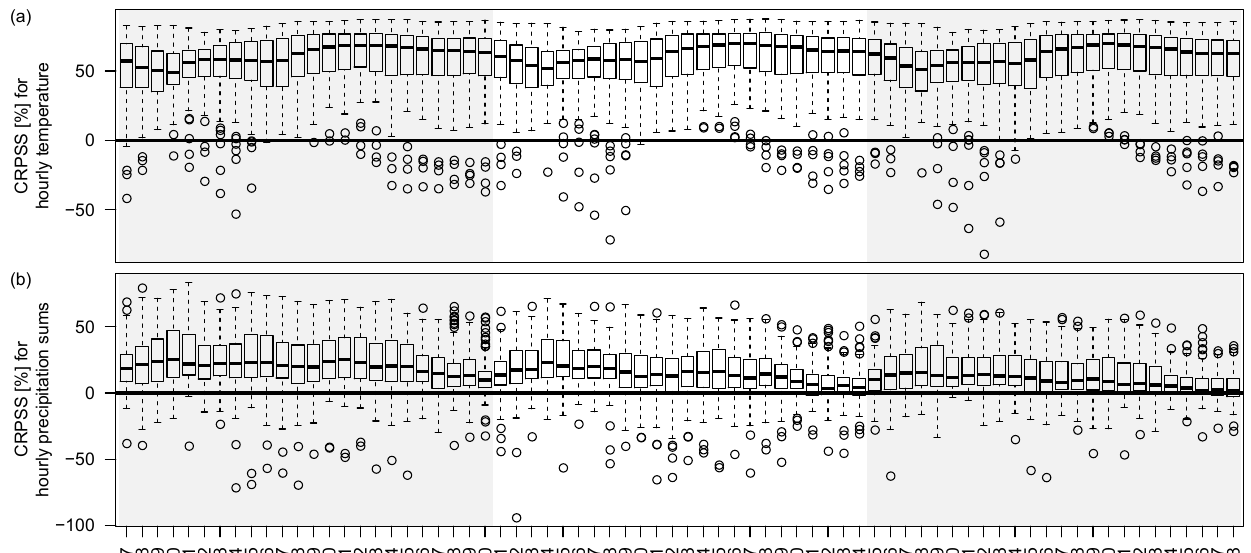
Figure 7. Continuous ranked probability skill scores (CRPSS) for 2m temperature (a) and hourly precipitation sums (b) based on station- wise mean empirical CRPS values (50 + 1 members). The raw EPS is used as a reference. CRPSSs are shown for each individual forecast step from + 7 to + 78 after model initialization. CRPSSs above 0 (bold black line) show that the postprocessed hourly forecasts outperform the raw EPS.